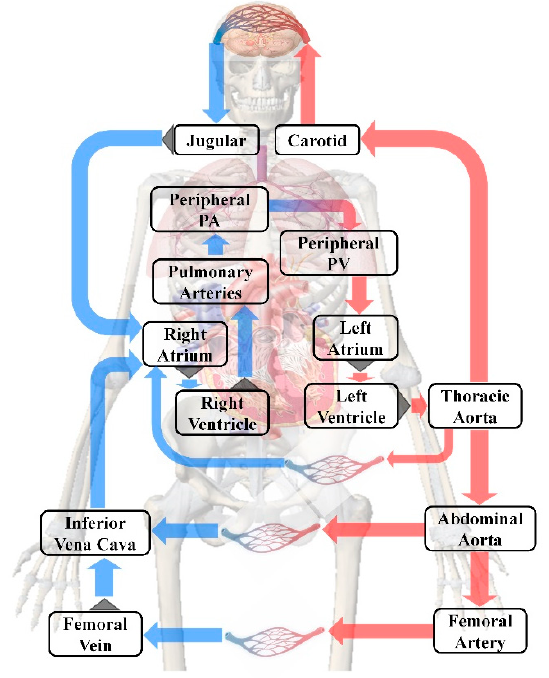
Figure 5. Schematic diagram of the human blood circulation model.